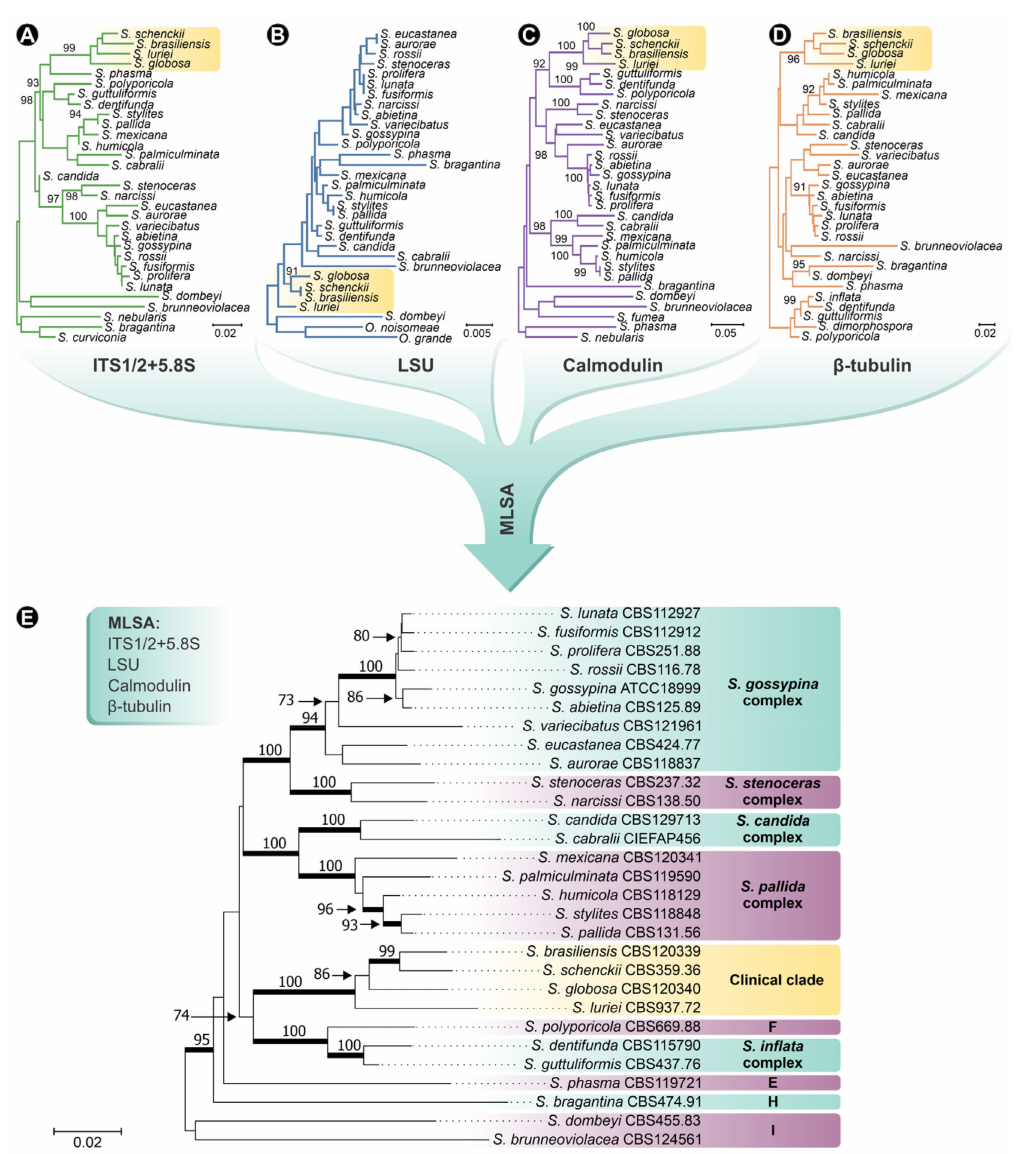
Figure 1. Phylogenetic analysis of Sporothrix species. Phylogenetic tree inferred using the Neighbor- Joining method, with 1000 bootstrap replicates performed in MEGA 7, based on ( A ) the internal transcribed spacer (ITS) sequences; ( B ) partial sequences of the large subunit (LSU) of the rRNA; ( C ) partial sequences of the calmodulin (CAL) gene; and ( D ) partial sequences of the β -tubulin (BT2) gene of Sporothrix isolates. ( E ) Phylogeny reconstruction based on concatenated sequences of ITS, LSU, CAL, and BT2. Numbers close to the branches represent bootstraps values. Sequences were collected from GenBank (Supplementary Table